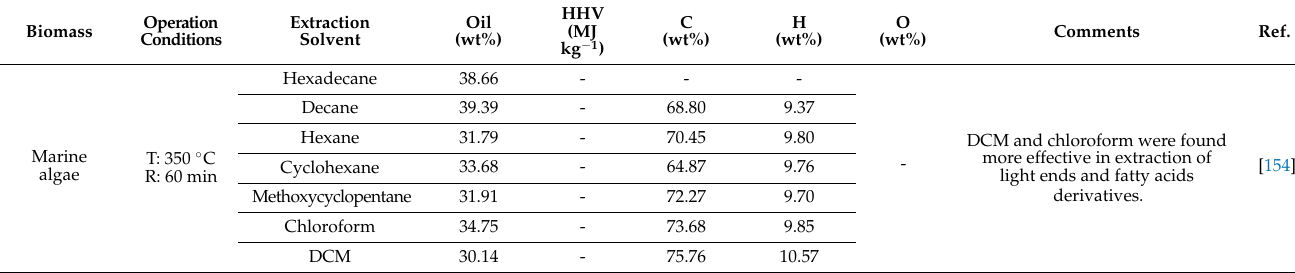
Table 13. Effect of extraction solvents on separation of products during